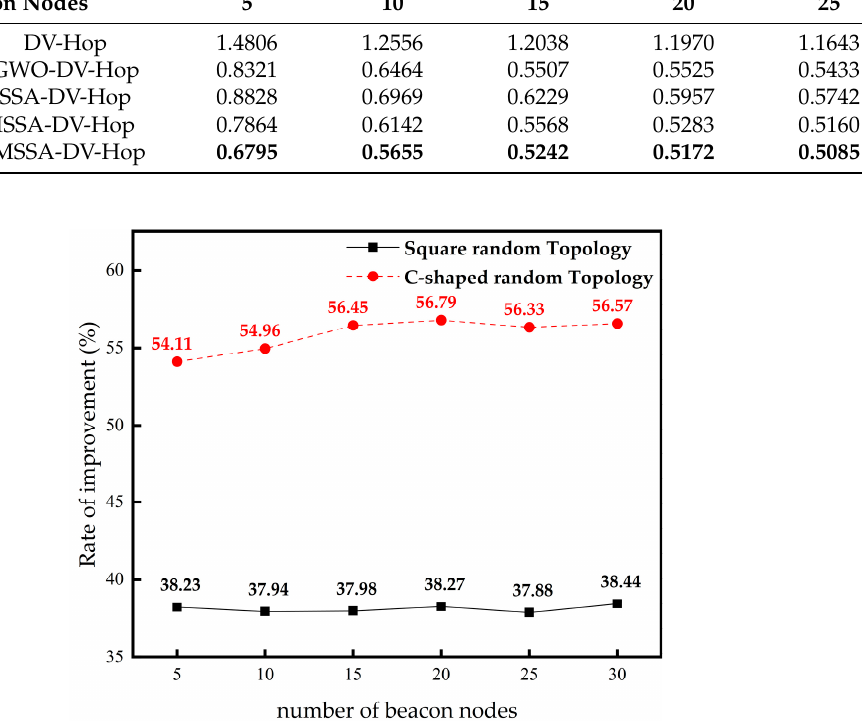
Table 7. Localization error in different number of anchor nodes in C-shaped random topology.